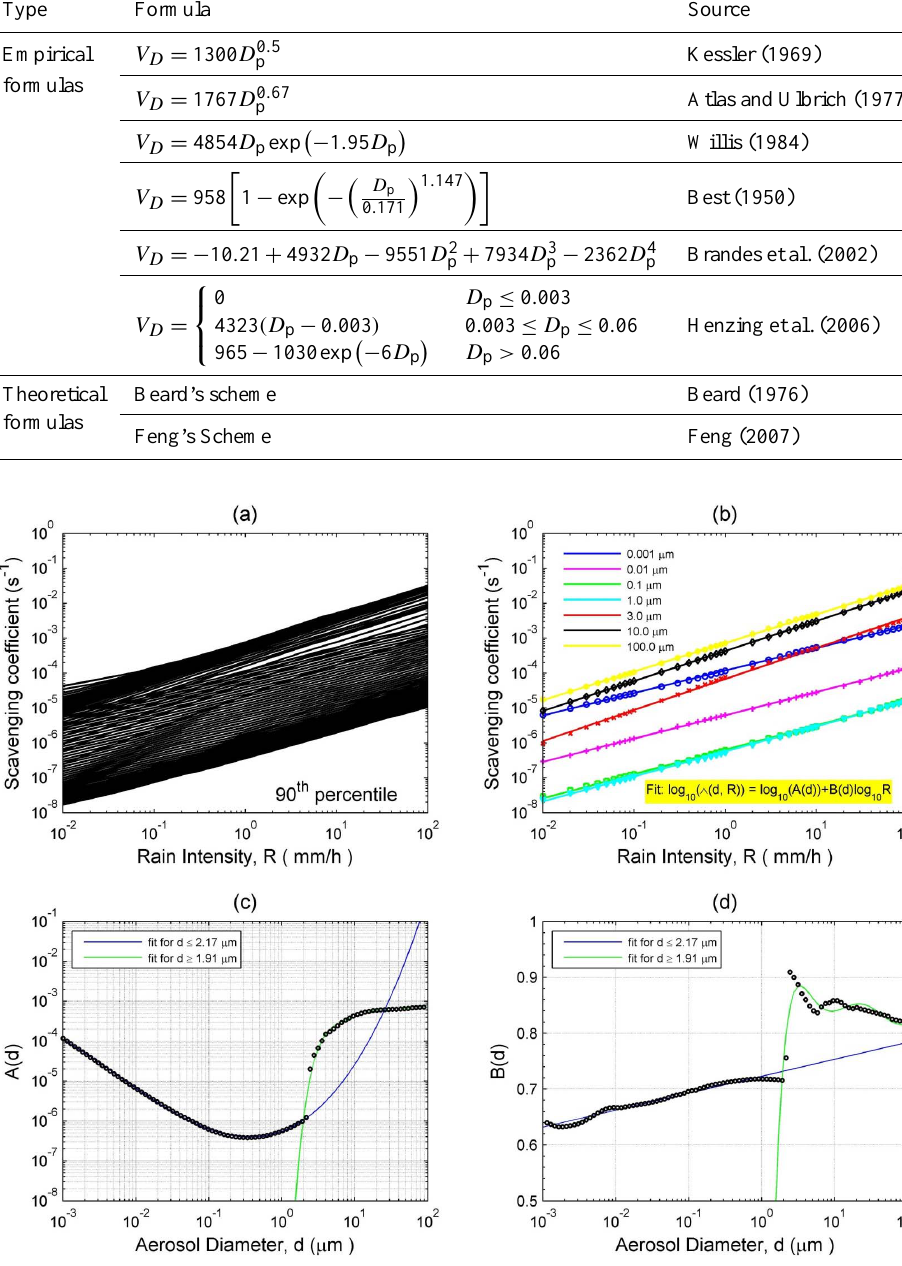
Linear regression analysis based on Eq. (4) was performed for all 100 lines and the squares of the resulting correla- tion coefficients were very high, ranging from 0.9963 to